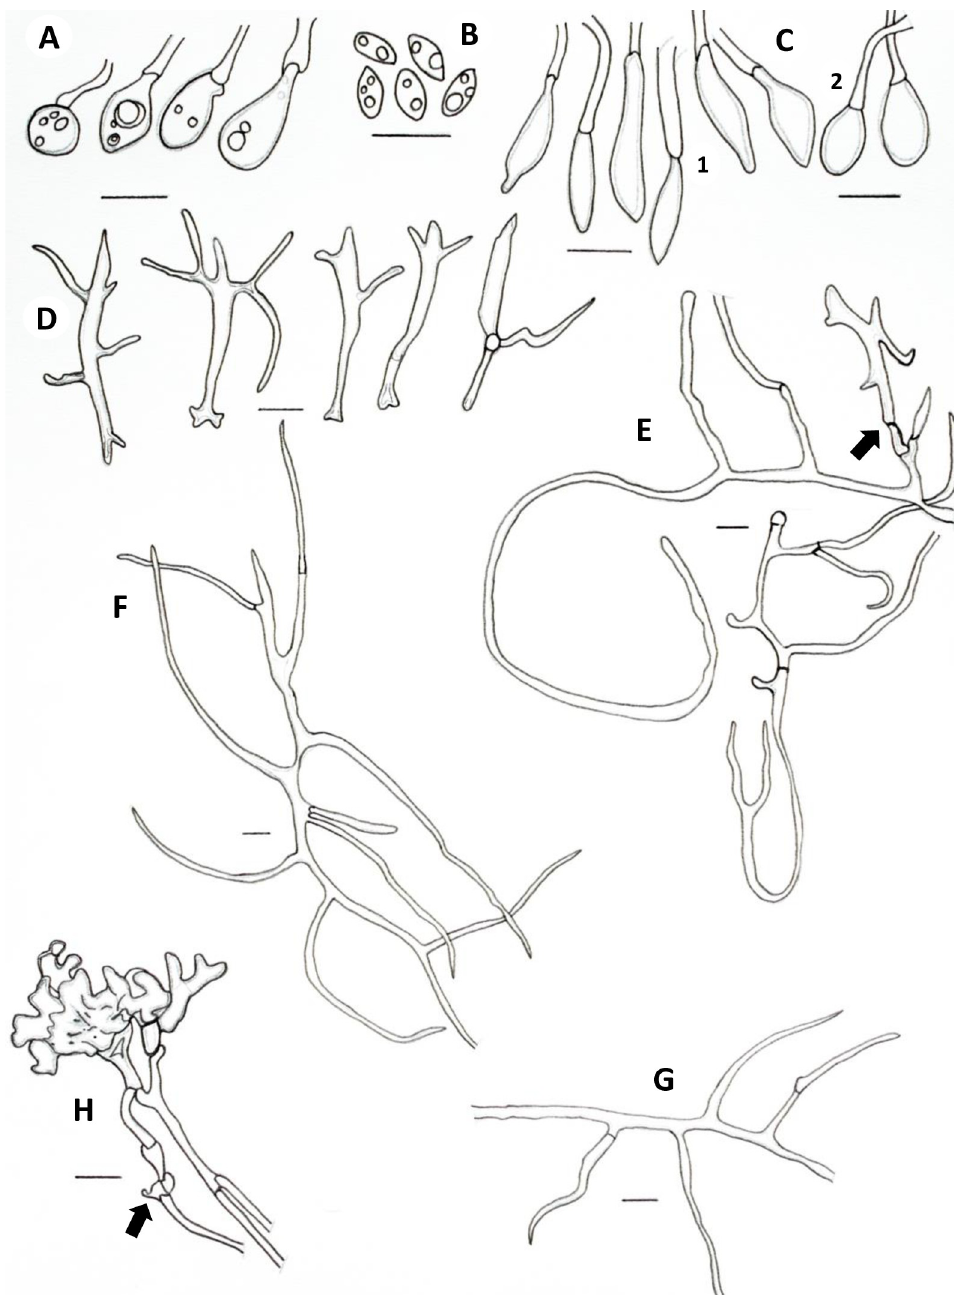
Fig 3. Microscopic features of A . yasuniensis . A. Basidioles. B. Basidiospores. C. Cystidioles. C1 of the ventricose type and C2 oblong-like type. D. Thick-walled distinctive stalks of tramal hyphae. E. Generative hyphae with a thick-walled distinctive stalk pointed by the arrow. F. Skeletal-binding hyphae from context. G. Section of skeletal-binding hyphae from stipe. H. Generative hyphae from cuticle with melanized cuticle cells (arrow pointing to a clamp connection). Scale bars = 10 μ